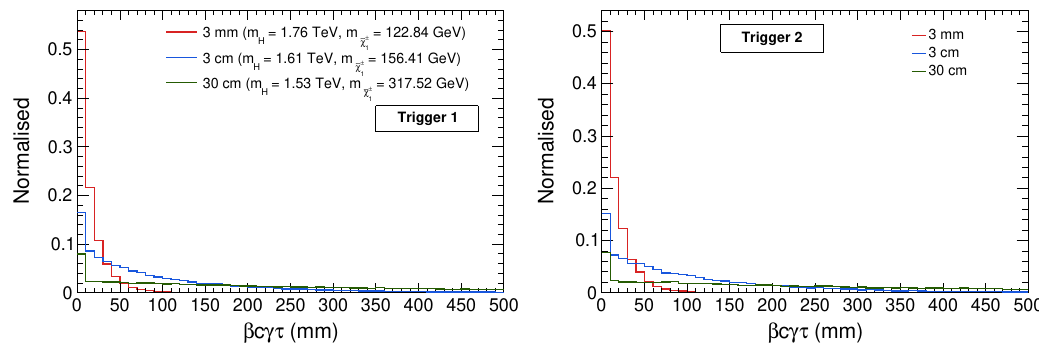
Figure 22. The normalised distribution of mean decay length for the three LLCP scenario after requiring Trigger 1 (left) and Trigger 2 (right) along with additional selection criteria.